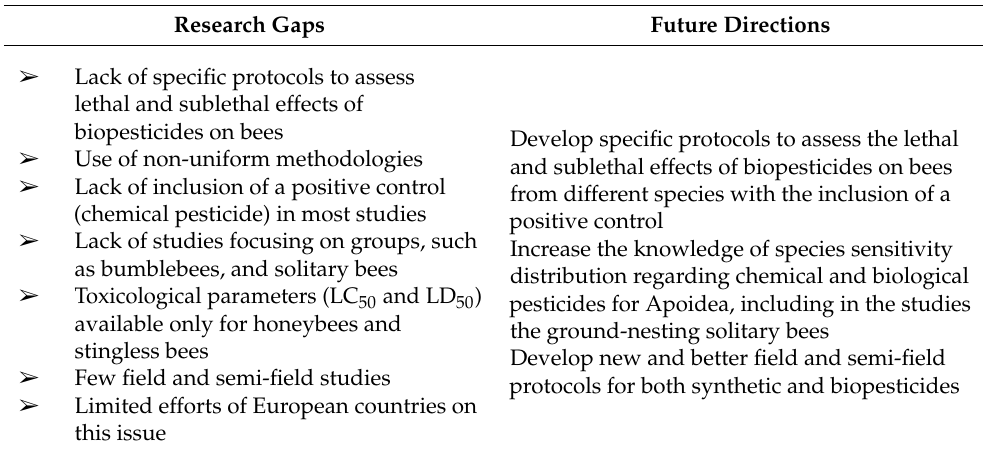
Figure 1. ( A ) Number of analysed papers assessing the risk of botanical biopesticides for bees by country; ( B ) number of analysed papers regarding the different groups of bees (honeybees, bumblebees, stingless bees, and solitary bees); ( C ) number of analysed papers concerning the different classes of botanical biopesticides. Table 4. Overview of the research gaps in the literature regarding the effects of botanical biopesticides and bees and future